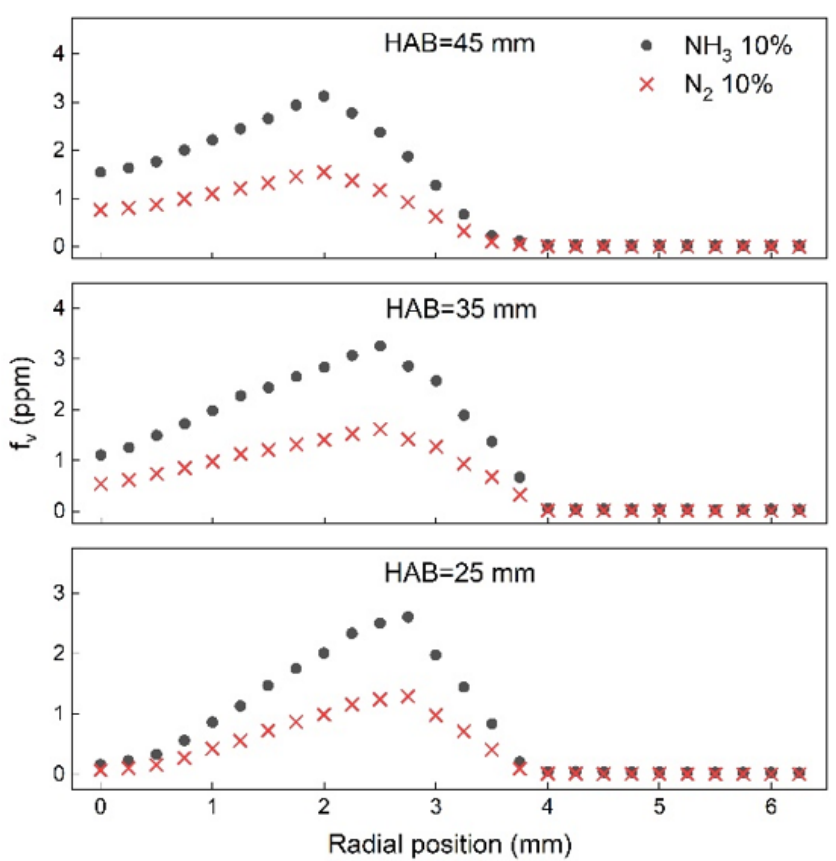
Figure 8. Radial distribution of the SVF for 10% of NH 3 and N 2 by vol. added to ethylene diffusion flame. The C 2 H 4 was supplied at constant flow rate of 0.18 LPM.